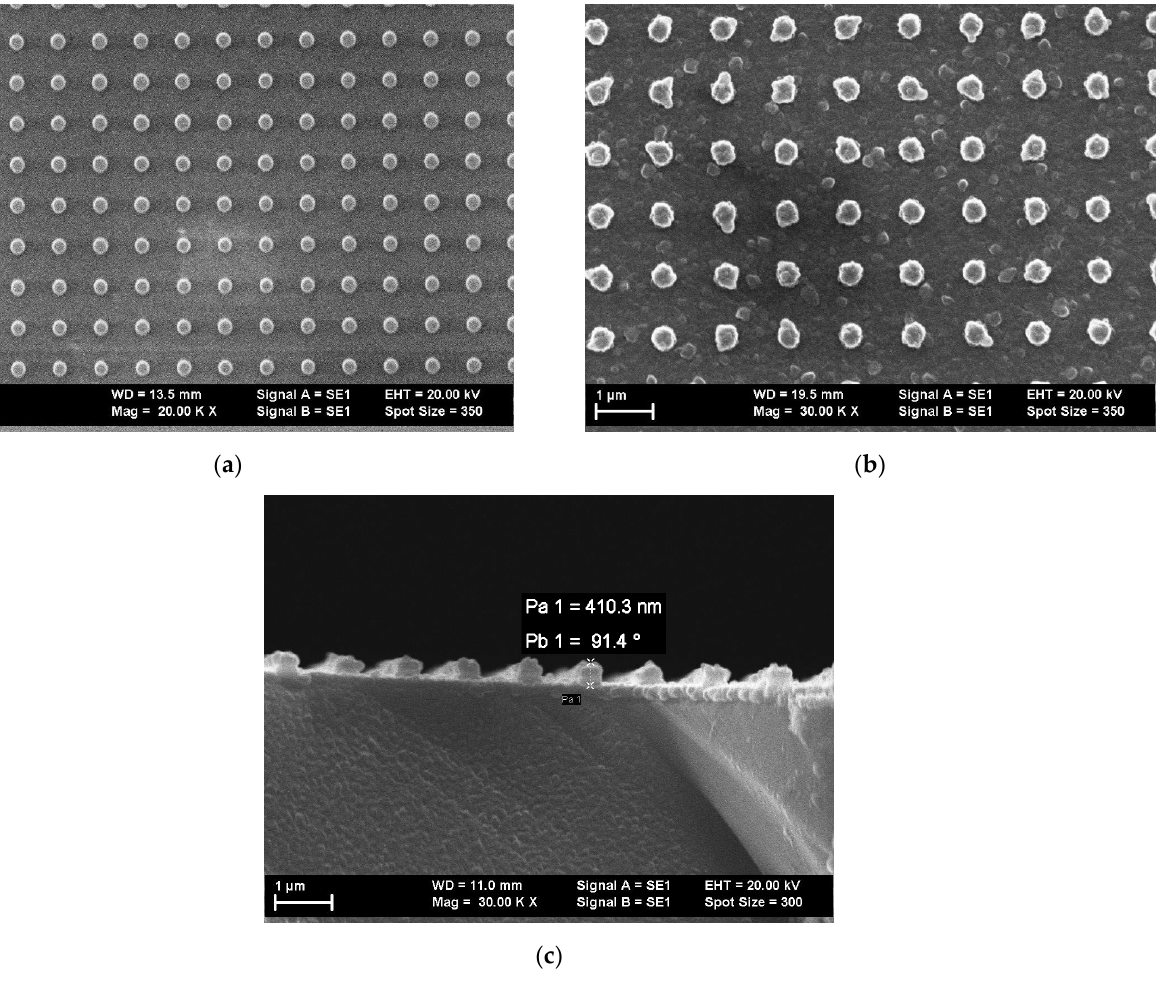
Figure 2. SEM images of: nano-patterned polymeric photoresist ( a ); nano-patterned Al layer ( b ); nano-patterned Al layer cross-section at a sample tilt angle of ~90° ( c ).